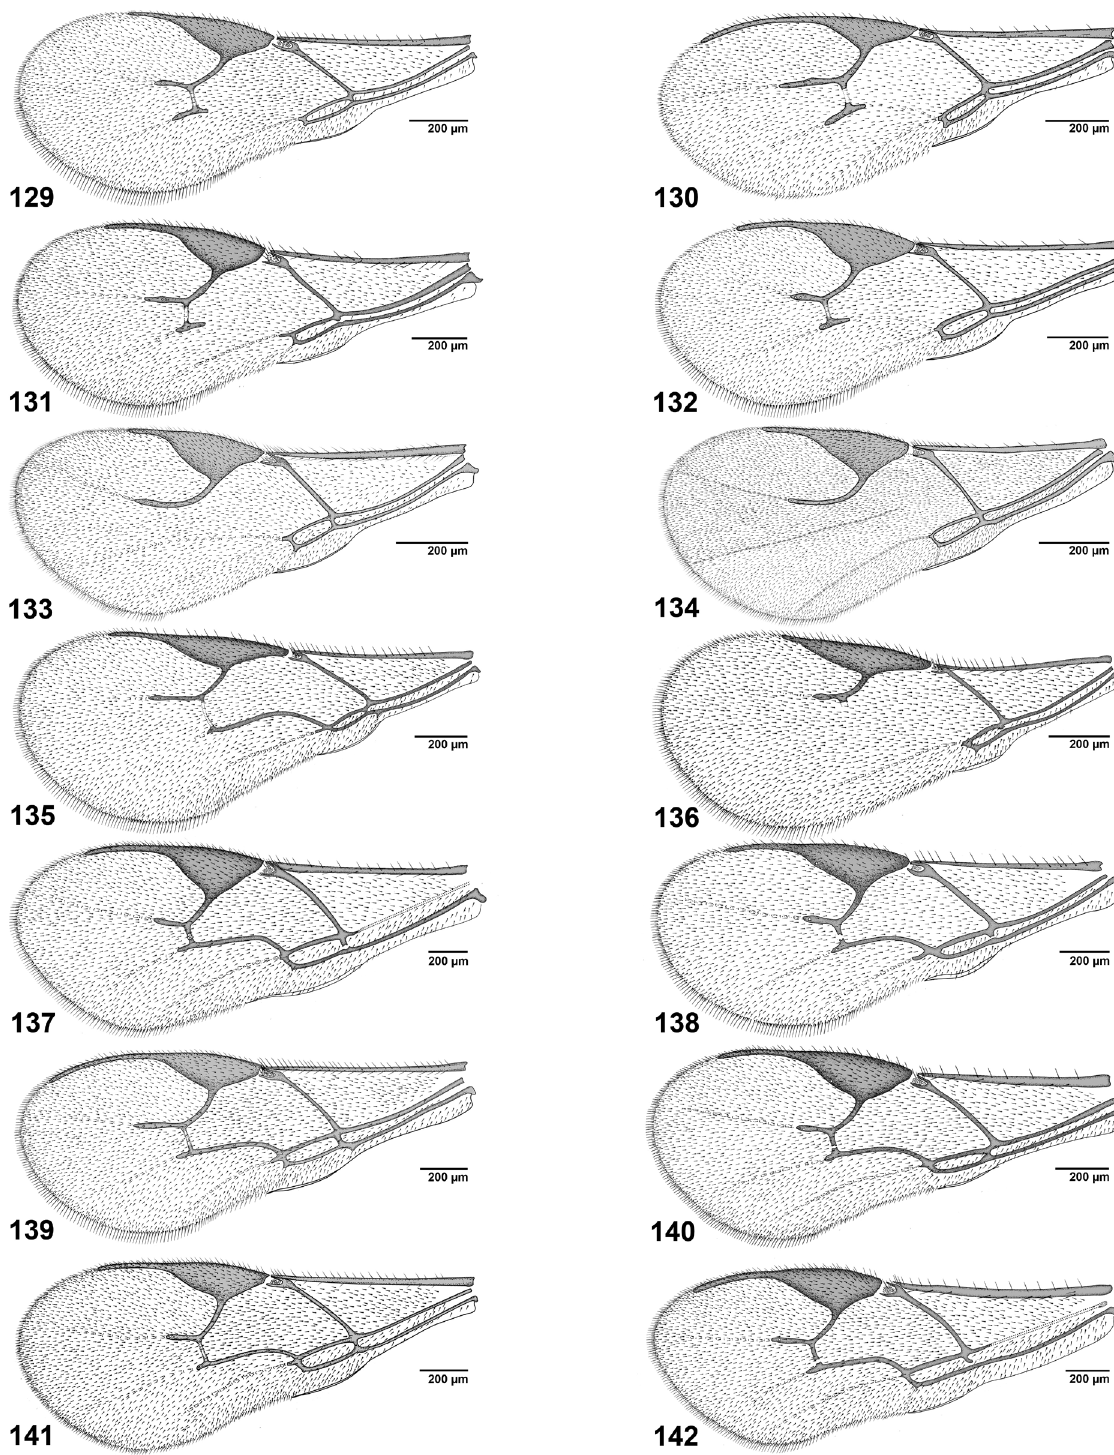
Figs 129–142. Forewing (♀): 129 . Lysiphlebus desertorum . 130 . Lysiphlebus fabarum . 131 . Lysiphlebus fritzmuelleri . 132 . Lysiphlebus testaceipes . 133 . Monoctonia pistaciaecola . 134 . Monoctonia vesicarii . 135 . Monoctonus crepidis . 136 . Monoctonus mali . 137 . Pauesia abietis . 138 . Pauesia anatolica . 139 . Pauesia antennata . 140 . Pauesia cedrobii . 141 . Pauesia hazratbalensis . 142 . Pauesia picta